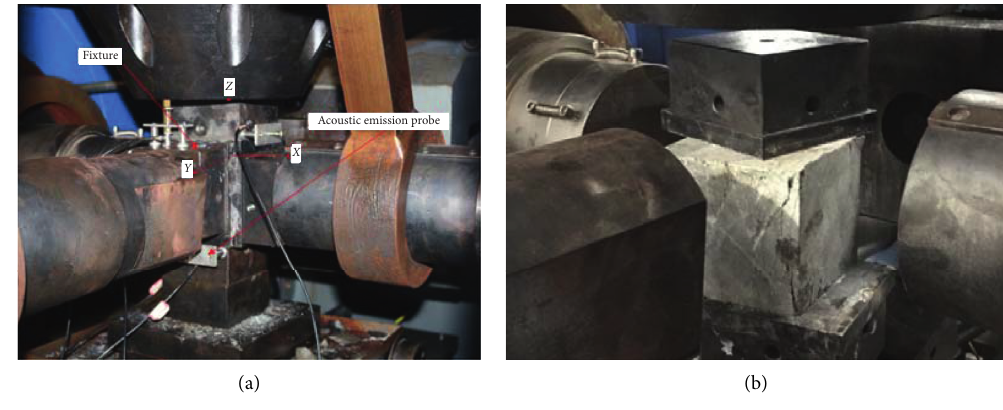
Figure 9: Experimental process